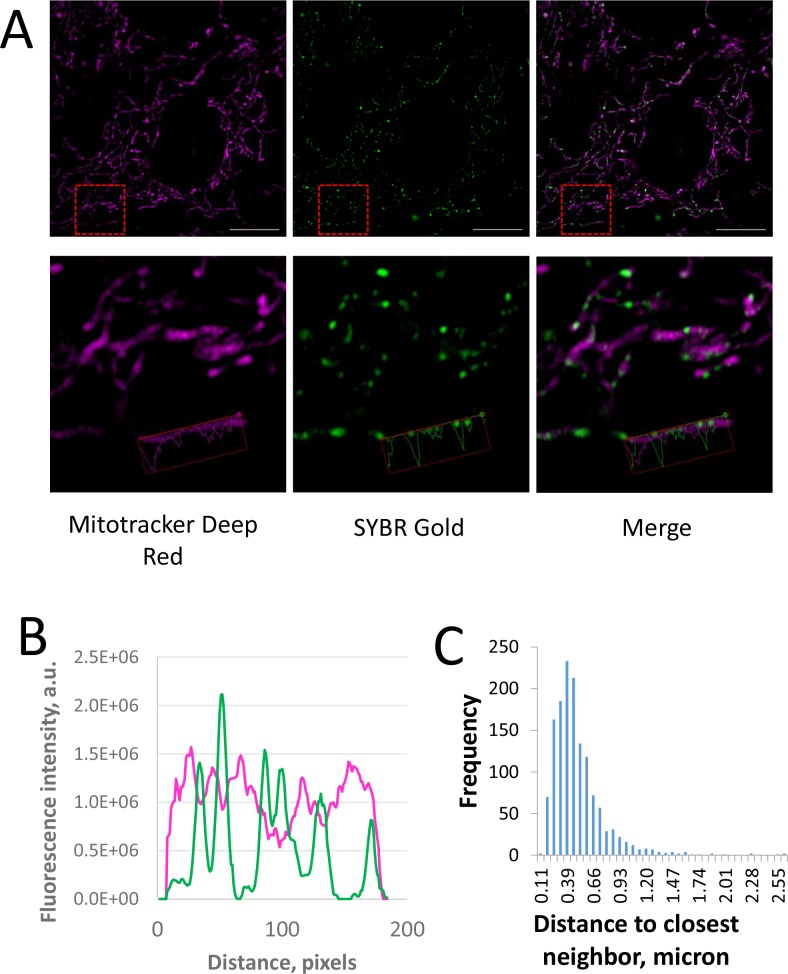
Comparison of confocal (cyan) and SIM (yellow) imaging of live cells labelled with SYBR Gold.A. Representative images (single optical slices). The same objective 100x 1.46 Oil TIRF and the same sampling (50 nm/pixel) is used for both LSM and SIM images. Left column shows entire field of view; Scale bar 10 μm; ROI is marked with red dashed line; ROI is shown in the right column with higher magnification (scale bar 1.25 μm). B. An intensity profile across two nucleoids (marked as a red arrow on higher magnification panels) in confocal (orange) and SIM (cyan) channels. C. Intensity profiles of fluorescent bead (red) and mitochondrial nucleoids (cyan) in SIM images. Further, we acquired SIM 3D datasets of live cells co-stained with SYBR Gold and Mitotracker Deep Red. Mitochondrial nucleoids appeared as bright spots within mitochondria, frequently as rows with equal distances between neighbors (Fig 8A). Distribution of distances between neighbor nucleoids showed a single maximum at 450 nm approx. (Fig 8B). This agrees with the values of 400–800 nm previously reported for fixed mammalian cells (Fig 1E in [45]). Interestingly, peaks in SYBR Gold channel intensity profiles correspond to local minima on the intensity profiles in Mitotracker Deep Red channel (Fig 8A, bottom panels), suggesting that freely diffusing mitochondrial matrix proteins are excluded from nucleoids; this agrees with previously reported exclusion of a mitochondria marker YFP-tagged cytochrome oxidase from nucleoids [45]. Thus, SIM imaging of SYBR Gold-stained cells enabled us to reproduce in live cells the observations of mitochondrial nucleoids, previously done in fixed cells and with diffraction-limited microscopy.